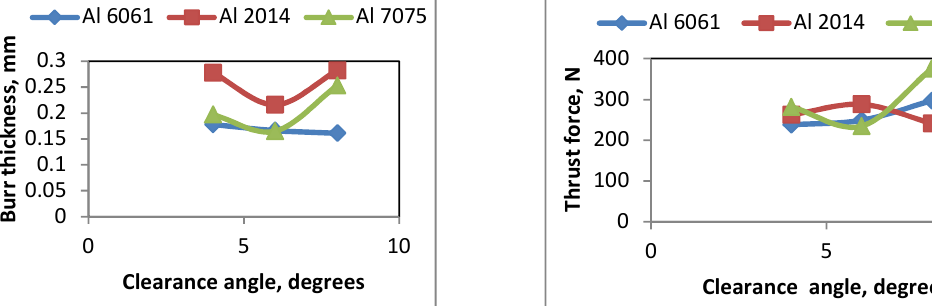
Fig. 12. Influence of increment in the clearance angle on burr thickness (SET-1)